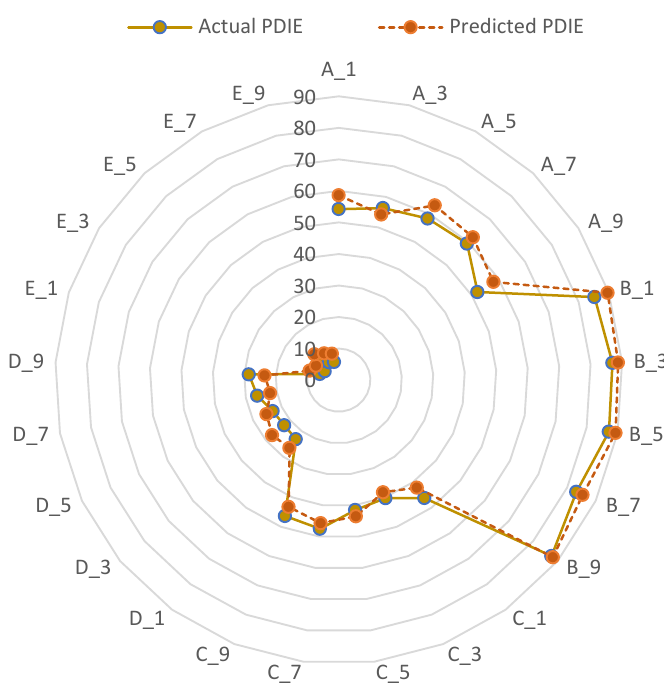
Figure 11. Demonstration of the actual and predicted PDIE values of chernozem soil on tests A_1 to E_10, implemented on layers A – E, respectively.